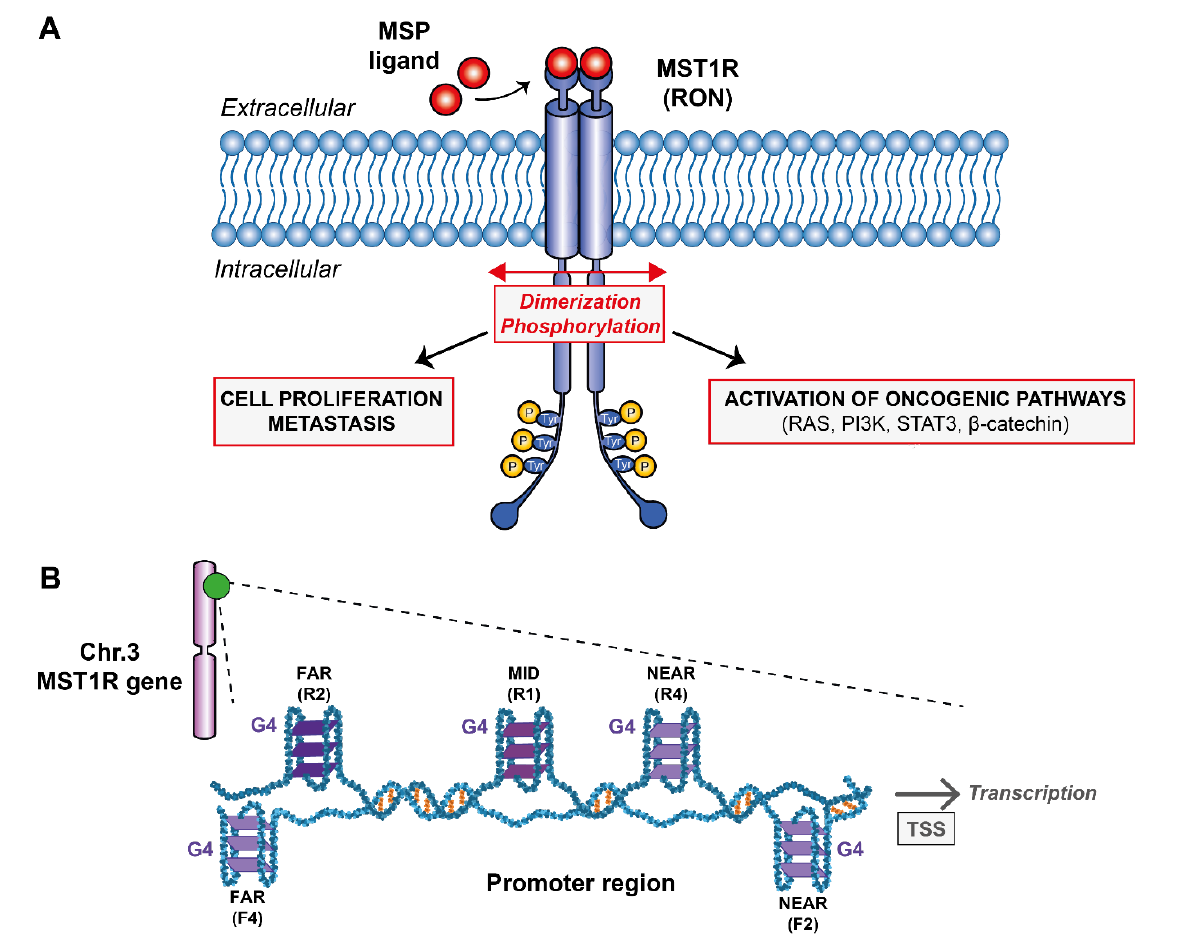
Figure 1. ( A ) Schematic representation of the G-quadruplexes formed within MST1R promoter region and their potential role on transcription. ( B ) Downstream signaling pathways after MST1R activation by dimerization and phosphorylation upon binding of MSP ligand.